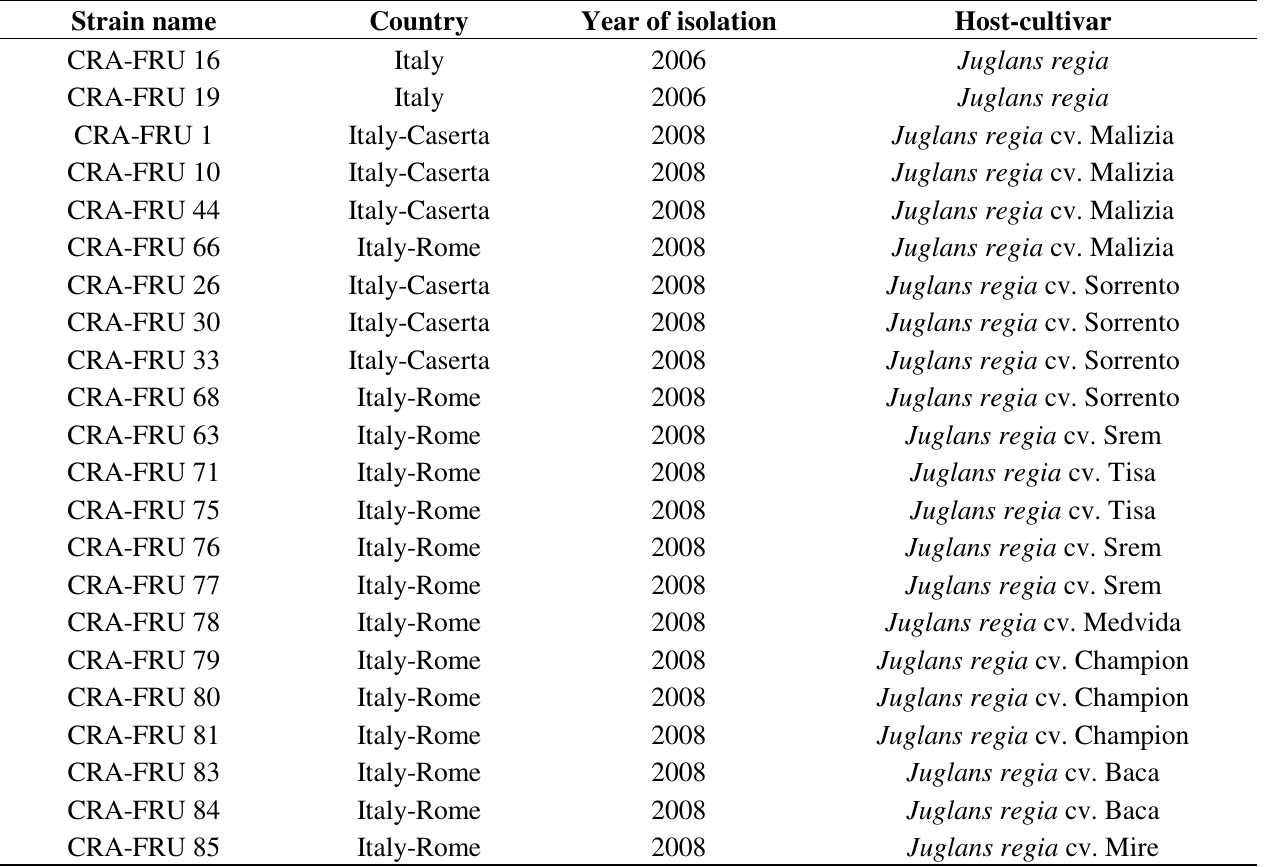
Table 1. List of Xanthomonas arboricola pv . juglandis strains used in this